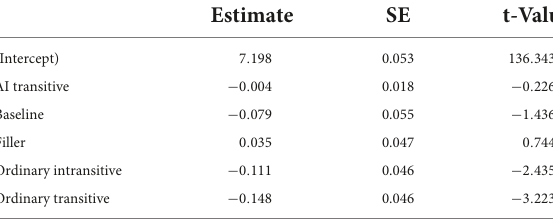
TABLE 6 Fitted mixed-effect generalized linear model for the response times.